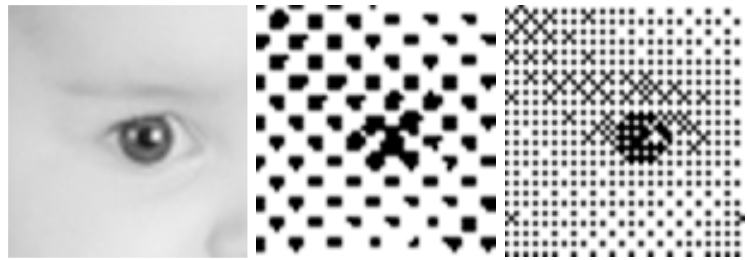
Figure 2. Sample graph showing continuous-tone image, amplitude-modulated (AM) screening image, and frequency-modulated (FM) screening image from left to